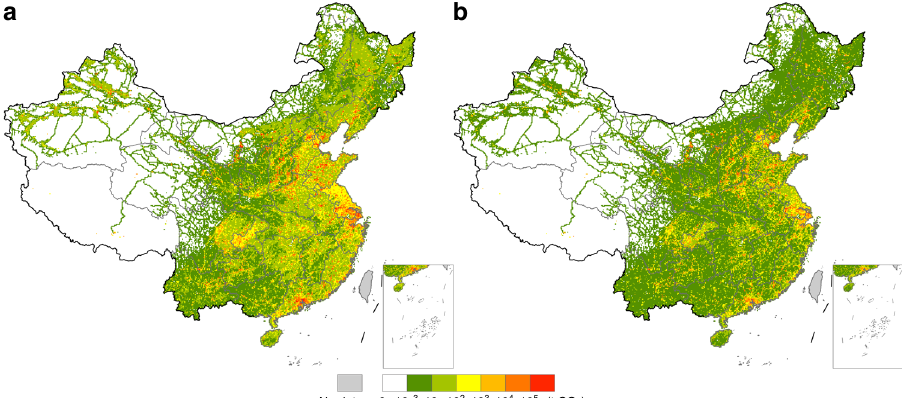
Fig. 6 Carbon footprint hotspot maps driven by two different categories of fi nal demand of the United States. a shows the carbon footprint hotspots driven by household consumption, and b shows the carbon footprint hotspots driven by gross fi xed capital formation.